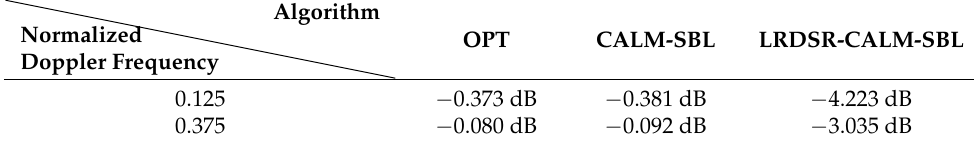
Table 5. SINR loss comparison of CALM-SBL and